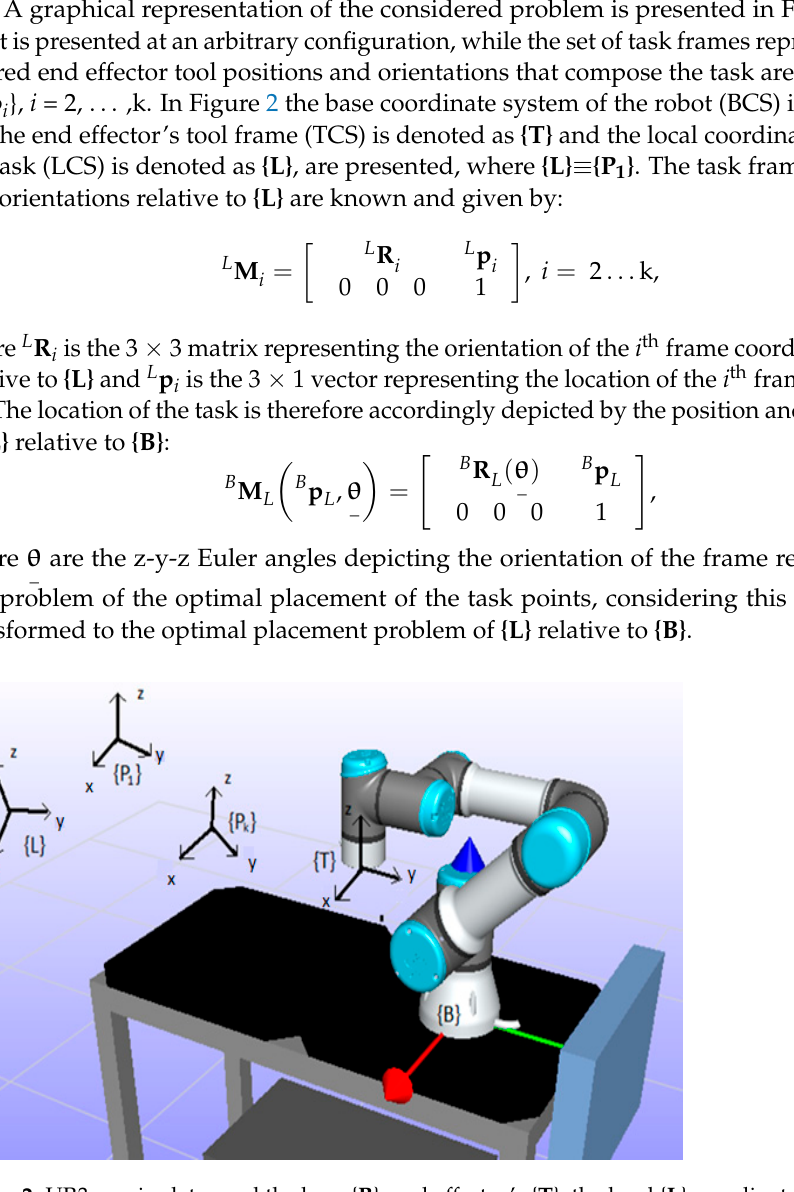
Figure 2. UR3 manipulator and the base { B }, end effector’s { T }, the local { L } coordinate systems, and the task frames { p i }. the task frames { p i